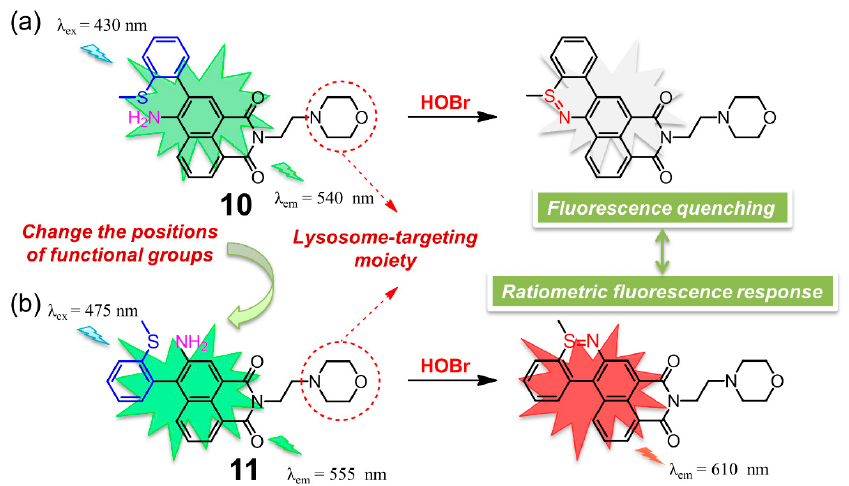
Figure 11. Chemical structures of two lysosome-targeting fluorescent probes ( a ) 10 and ( b ) 11 based on 1,8-naphthalimide framework for selective detection of HOBr.